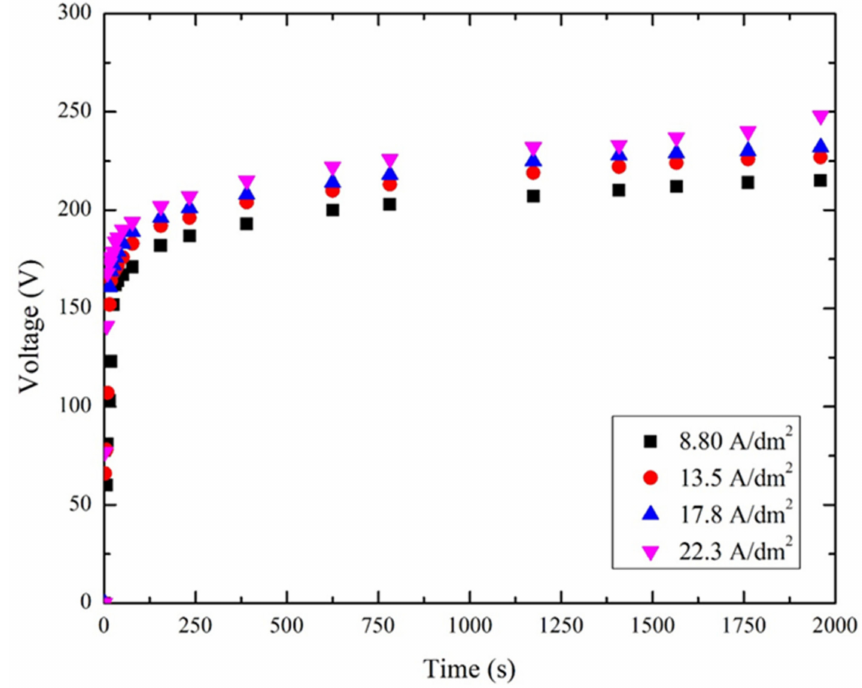
Figure 1. Voltage versus time curves of the PEO coating of Al 7075 samples under different current